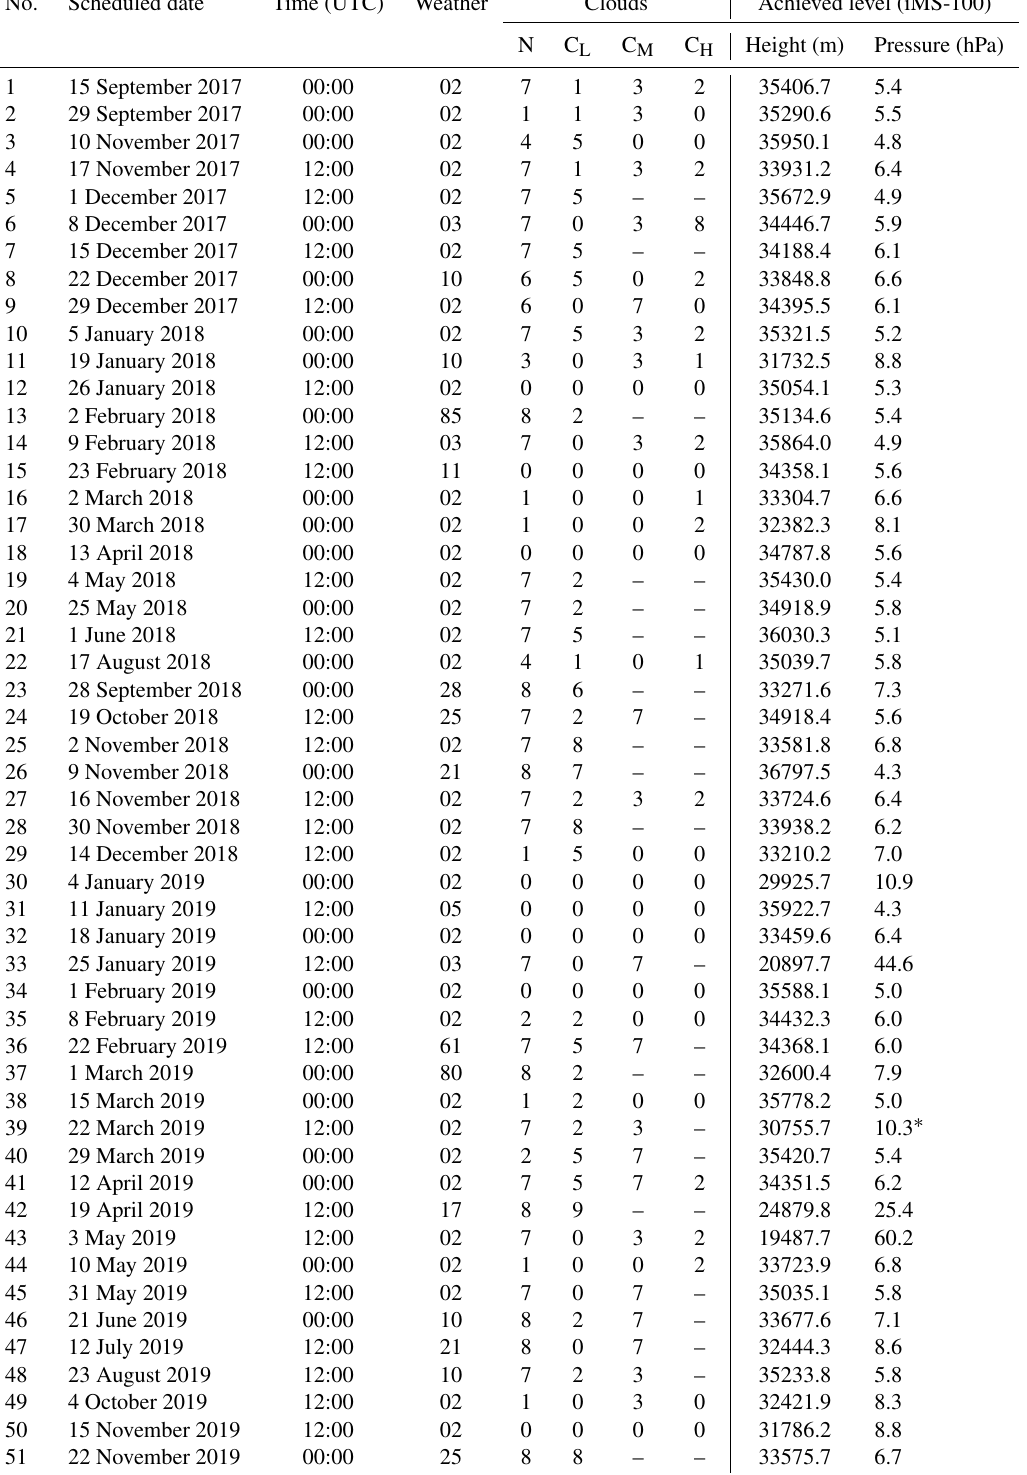
Table 6. List of dual sounding events with iMS-100 and RS92 used for comparison. The Weather code is according to the World Meteoro- logical Organization (WMO) code table